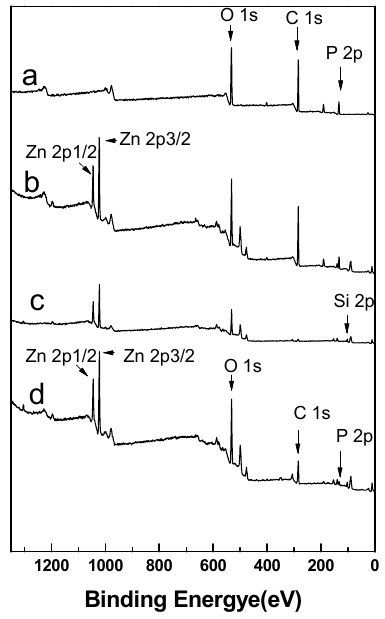
Figure 8. The X-ray photoelectron spectroscopy (XPS) survey scan of HDDPA ( a ) and Zn-HDDPA precipitates ( b ), hemimorphite without ( c ) or with ( d ) HDDPA treatment. Table 2. Atomic concentration of elements as determined by X-ray photoelectron spectroscopy (XPS). Species